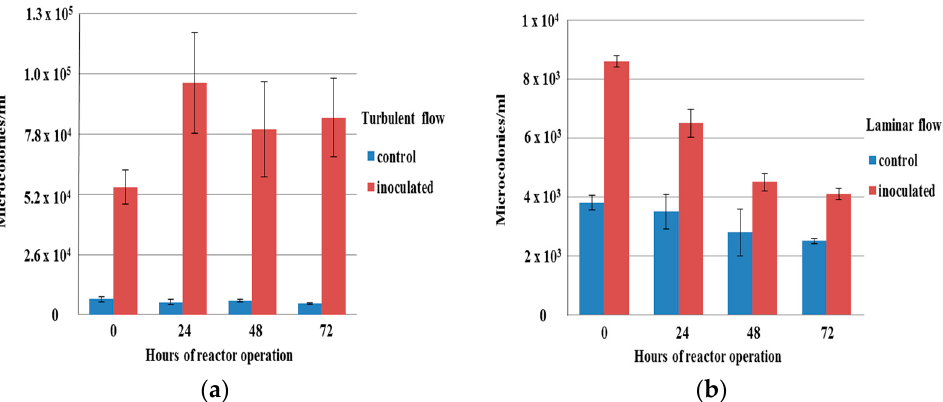
Figure 1. Concentration of microcolonies in the bulk water of reactor for both the control and inoculated cultures after 0, 24, 48, and 72 h ( a ) in turbulent flow and ( b ) in laminar flow.